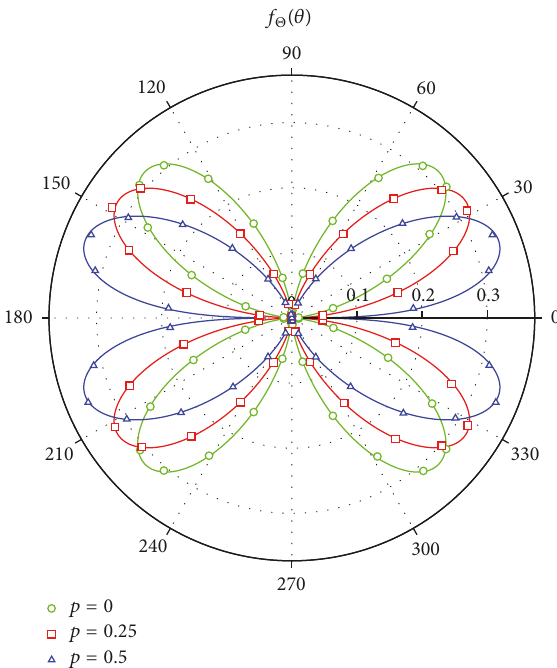
Figure 2: Empirical and theoretical 𝛼 - 𝜇 phase distribution with 𝜇 = 3 and irrelevant 𝛼 .